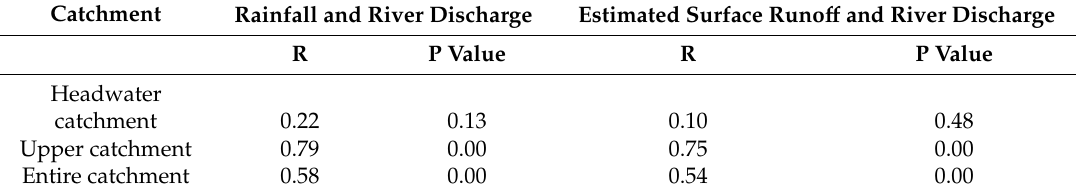
Table 6. Correlation of river discharge with rainfall and surface runo ff estimated based on rainfall and LULC changes.